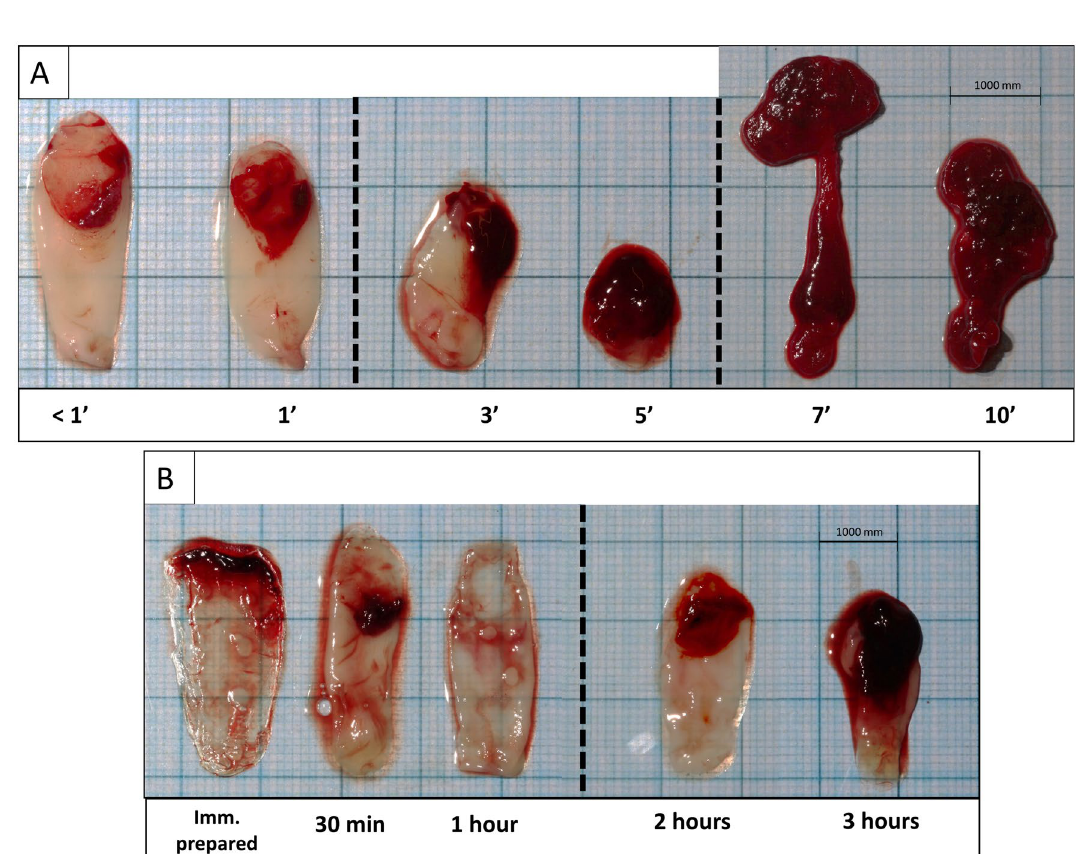
Figure 5. Morphology of the L-PRF membranes depending on the time before and after centrifugation (n = 3). ( A ) Timing between blood collection and centrifugation; ( B ) Timing between centrifugation and L-PRF membrane